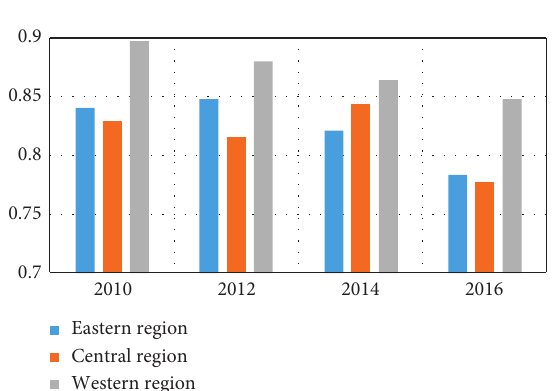
Figure 1: Changes of the operation efficiency in the three regions of China (2010–2016).